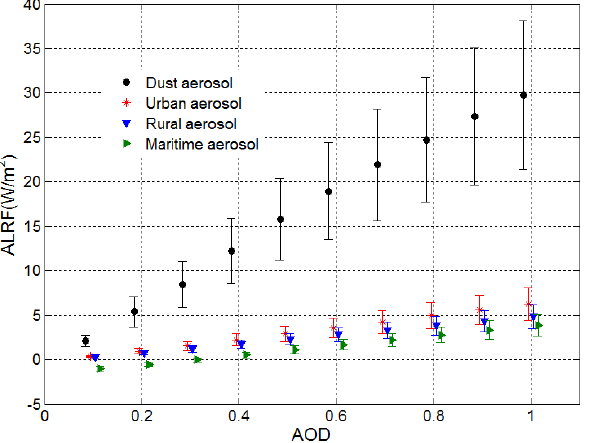
Figure 2. The aerosol longwave radiative forcing (ALRF) of different aerosol types varies with the aerosol optical depth (AOD). The solid symbols indicate the ALRF and the half-length of the vertical bars represents the Standard Deviations of the ALRF.